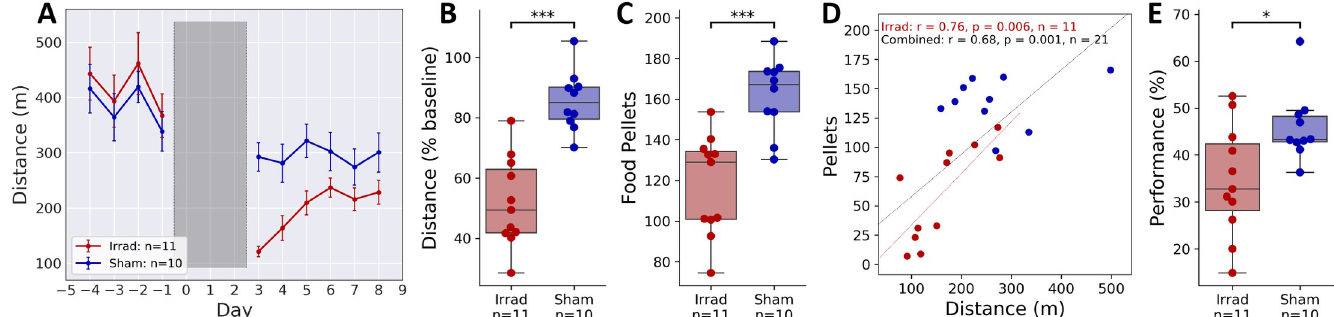
Fig 3. Reversal learning. “Performance” is the percentage of nose-pokes into the rewarded hole of the cognition wall. Performance line plots (E, F, H, I) display the mean performance over a 30 nose-poke rolling window. (A) Mean daily distances traveled. Grey shaded area indicates the three days of irradiation. (B) Distances travelled across the 6-day post-irradiation period normalized to the total on the day before irradiation. (C) Food pellets consumed per day across the 6-day post- irradiation period. (D) Correlation between VWRA and food consumption for each group and for the combined data. (E) Mean performance cumulative over the first night of reversal learning. � p < 0.05, ��� p <